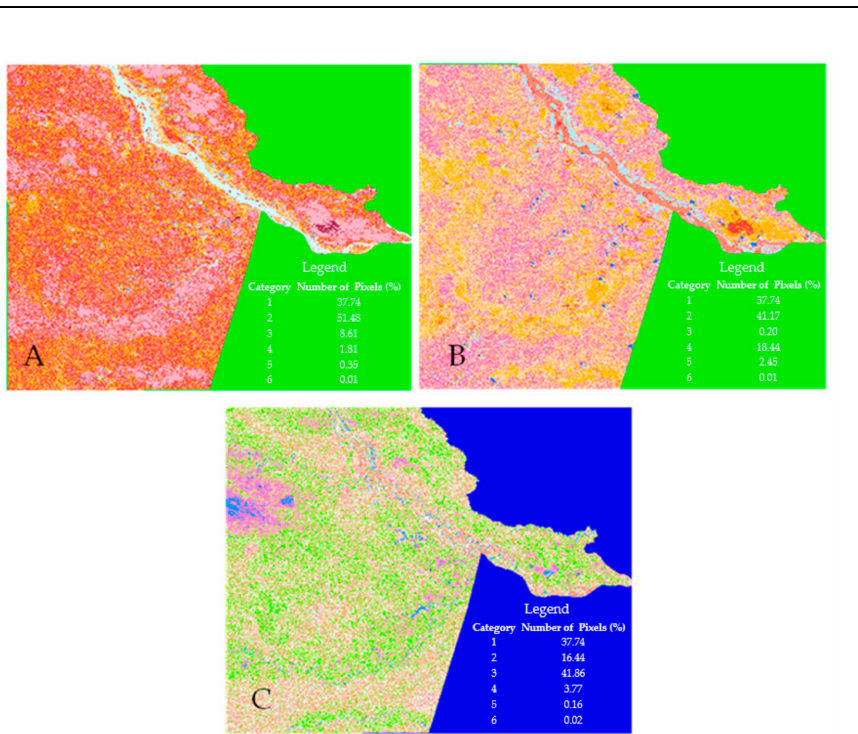
Figure 4. Unsupervised classification of the in the ITT Oil Block of the Ecuadorian Amazon region: ( A ) 2001; ( B ) 2014; and ( C ) 2017 with the PCI Geomatics